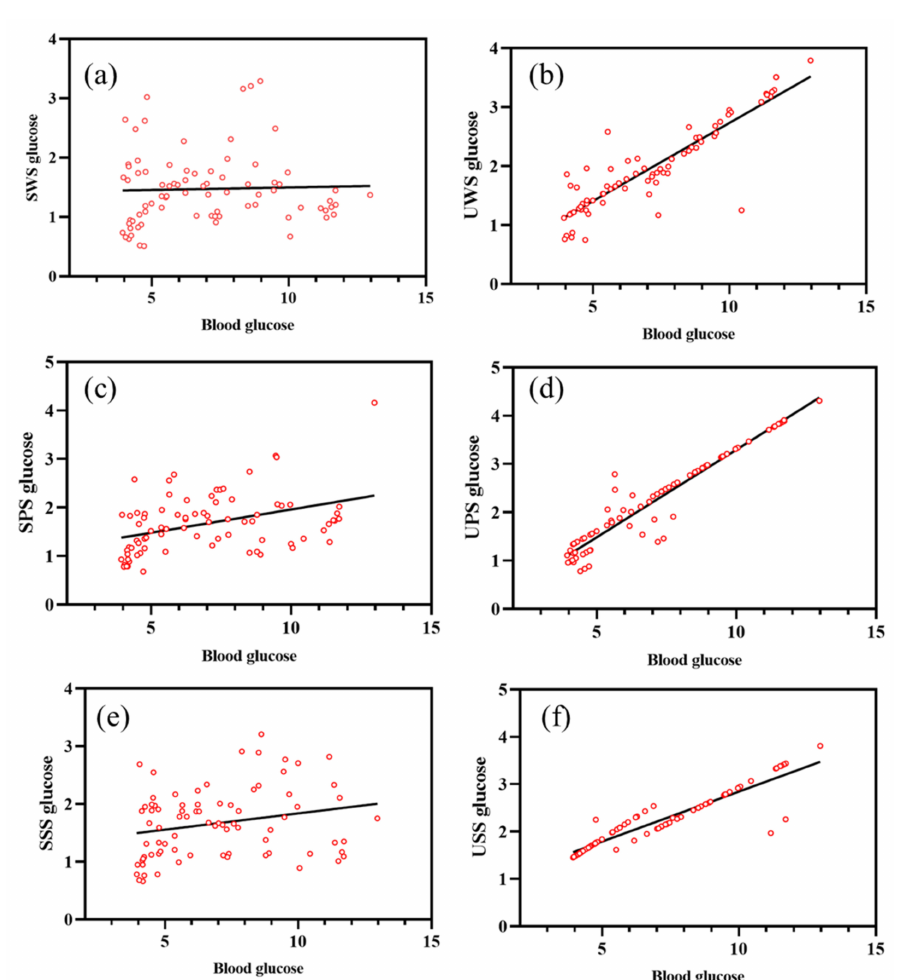
Figure 4. Correlation between salivary glucose of six saliva collection method and blood glucose. ( a ) The correlation between SWS glucose with blood glucose (R 2 = 0.001127, Sy. x = 0.6183), ( b ) The correlation between UWS glucose with blood glucose (R 2 = 0.8109, Sy. x = 0.3217), ( c ) The correlation between SPS glucose with blood glucose (R 2 = 0.1568, Sy. x = 0.5597), ( d ) The correlation between UPS glucose with blood glucose (R 2 = 0.9153 (maximum correlation), Sy. x = 0.2772), ( e ) The correlation between SSS glucose with blood glucose (R 2 = 0.05544, Sy. x = 0.5844), ( f ) The correlation between USS glucose with blood glucose (R 2 = 0.8492, Sy. x = 0.2236). Sy. x means standard error of estimate (also seen as